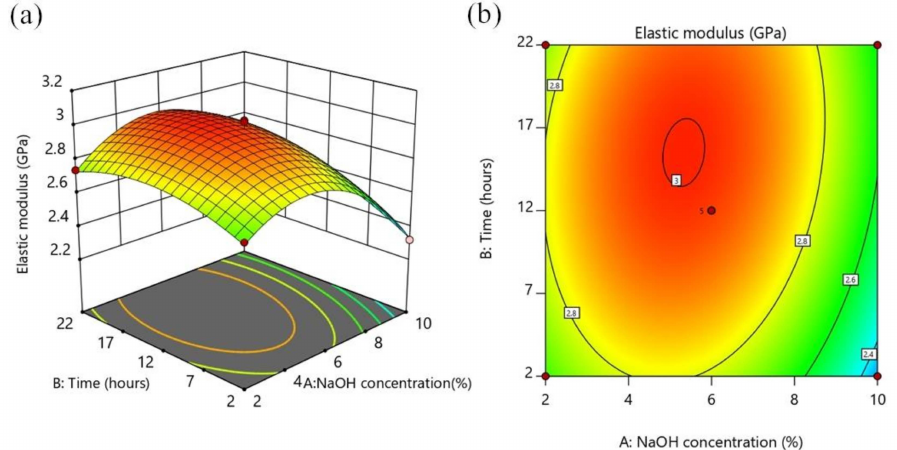
Figure 5. Effect of NaOH concentration and time on elastic modulus of coir fiber at a temperature of 40 ◦ C: ( a ) three-dimensional surface plot; ( b ) contour